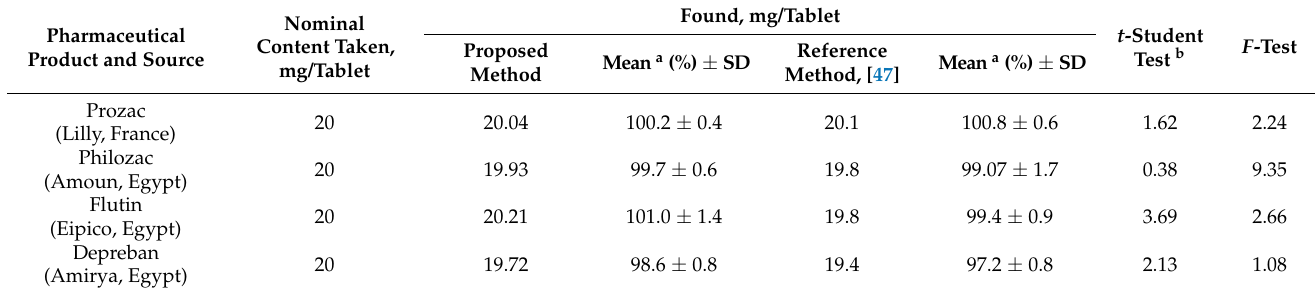
Table 5. Determination of FLX in different pharmaceutical preparations using ionophore (I) membrane-based sensor.